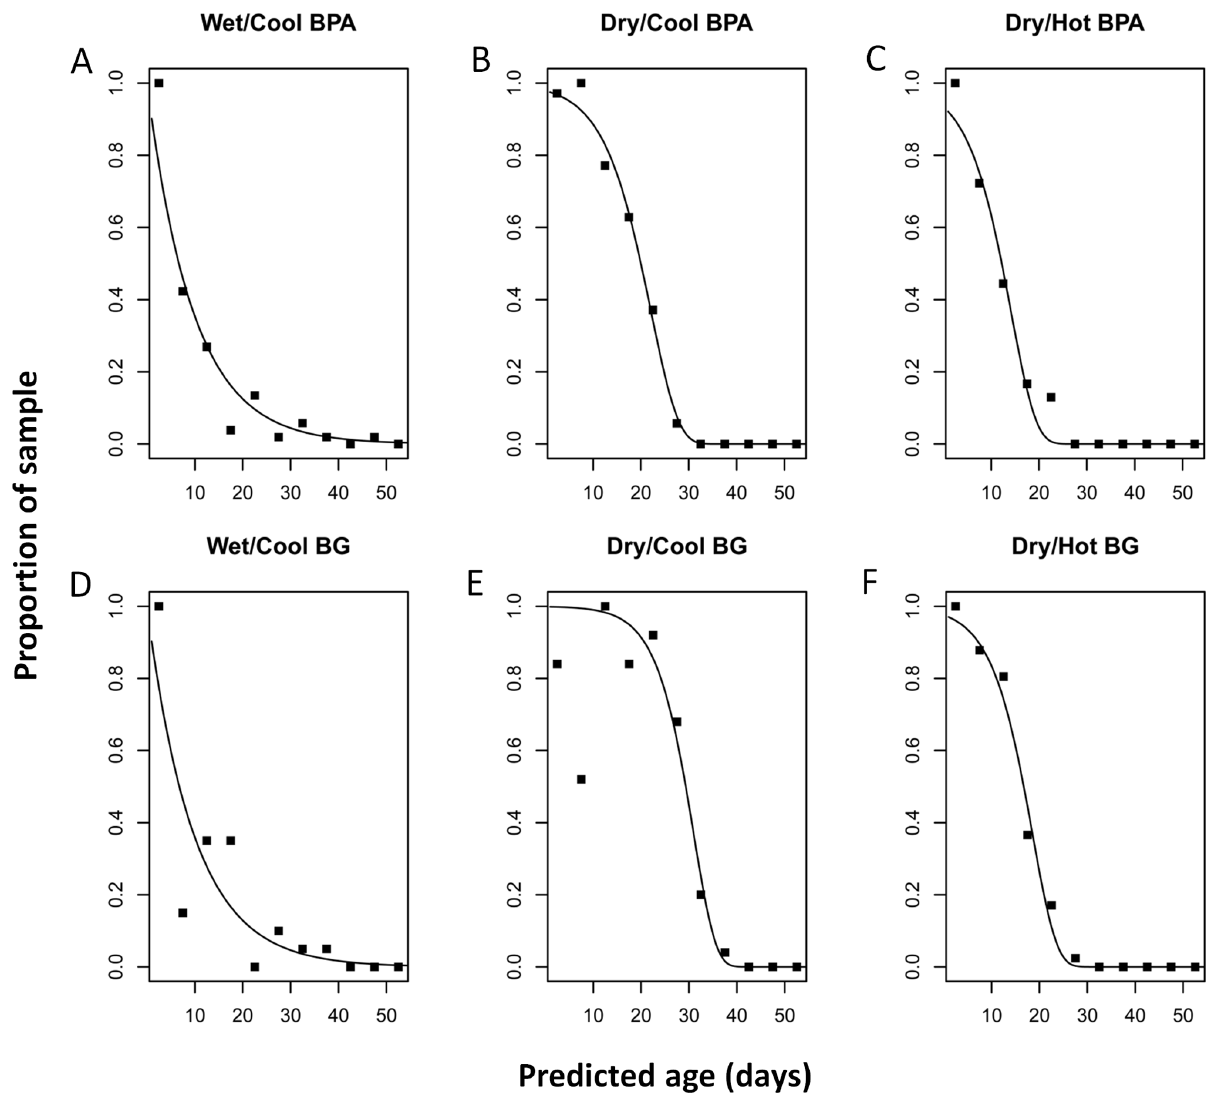
Figure 6. Observed and fitted data for the estimated age distributions of Aedesaegypti mosquitoes collected from Tri Nguyen village over three seasons. Age distributions are presented for BG trap (A–C) and backpack aspirator (BPA) collections (D–E). The exponential model was most appropriate for the wet/cool season for both collection methods, while the Gompertz model was most appropriate for dry/cool and dry/hot seasons. Model fit statistics are provided in Table